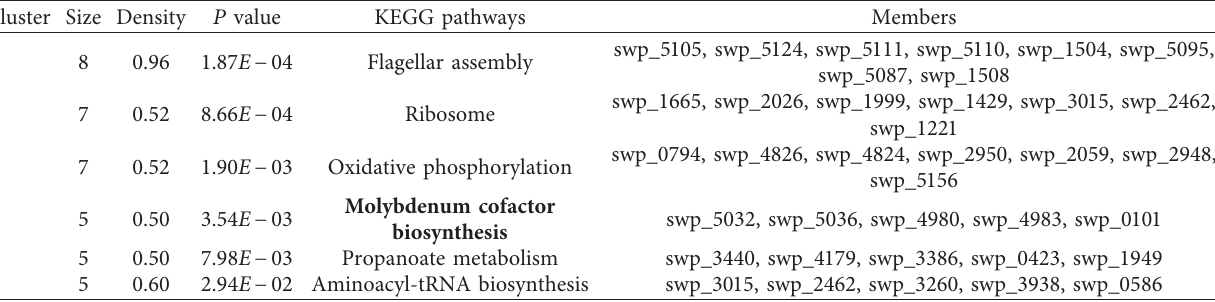
Table 2: The most representative KEGG pathway that was enriched in the modules identified from the cold shock condition. Cluster Size Density